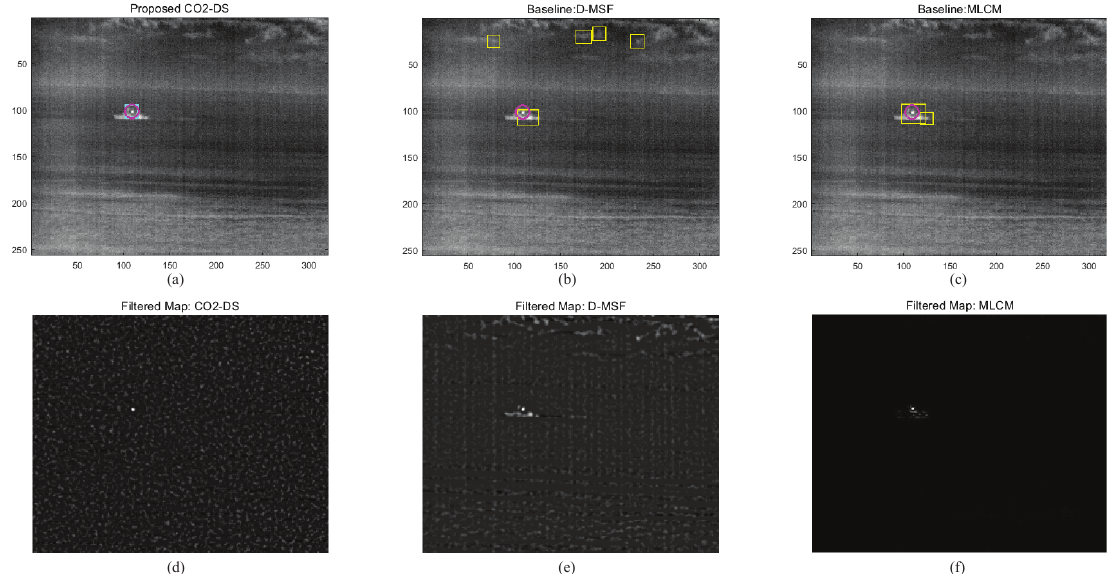
Figure 16. Comparative detection examples for cloud-clutter backgrounds: ( a – c ) detection results, ( d – f ) filtered maps.